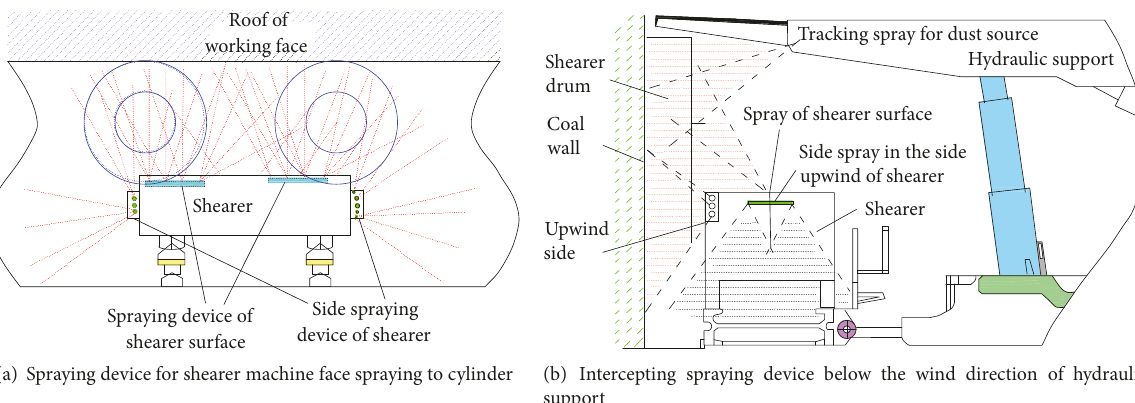
Figure 13: Prevention and control technology scheme of hydrogen sulfide in the air of tunnel.